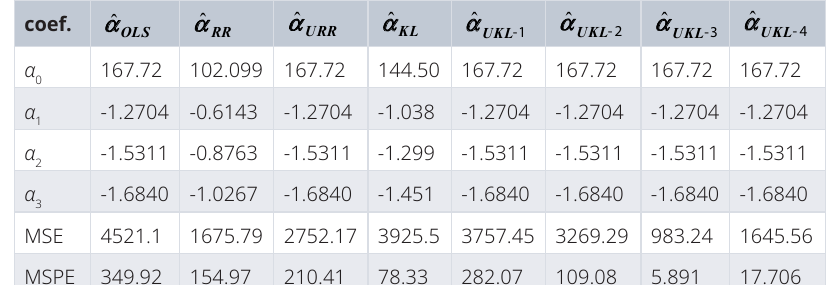
Table 3. Regression coefficients and